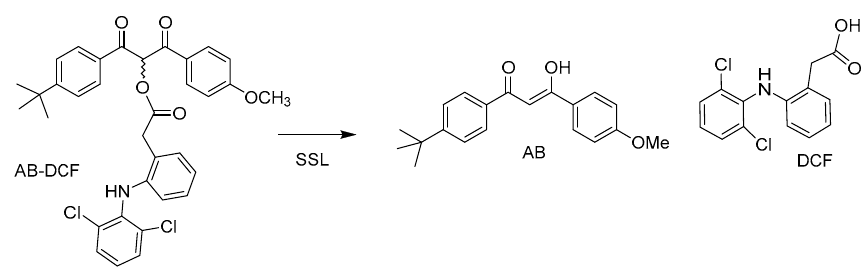
Scheme 3. Photorelease of AB and DCF from the dyad (AB-DCF).